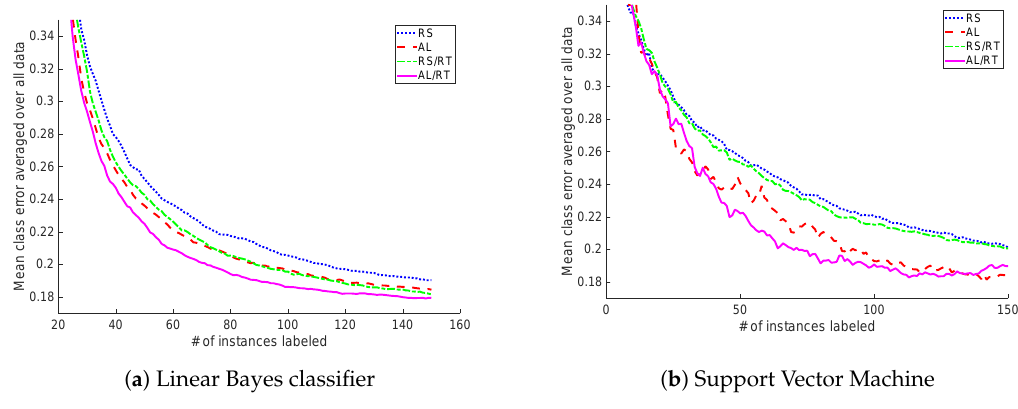
Figure 4. Learning curves for linear Bayes classifier ( a ) and support vector machine ( b ) for random sampling (RS), random sampling with removal of transitions (RS/RT), active learning (AL) and active learning with removal of transitions